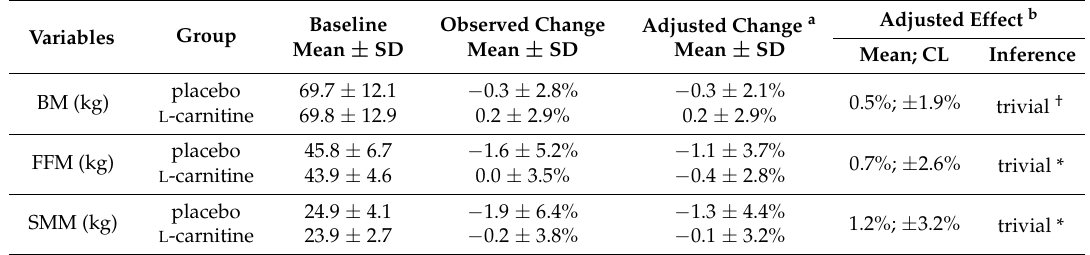
Table 2. Baseline and changes in the measures across a supplementation period in both